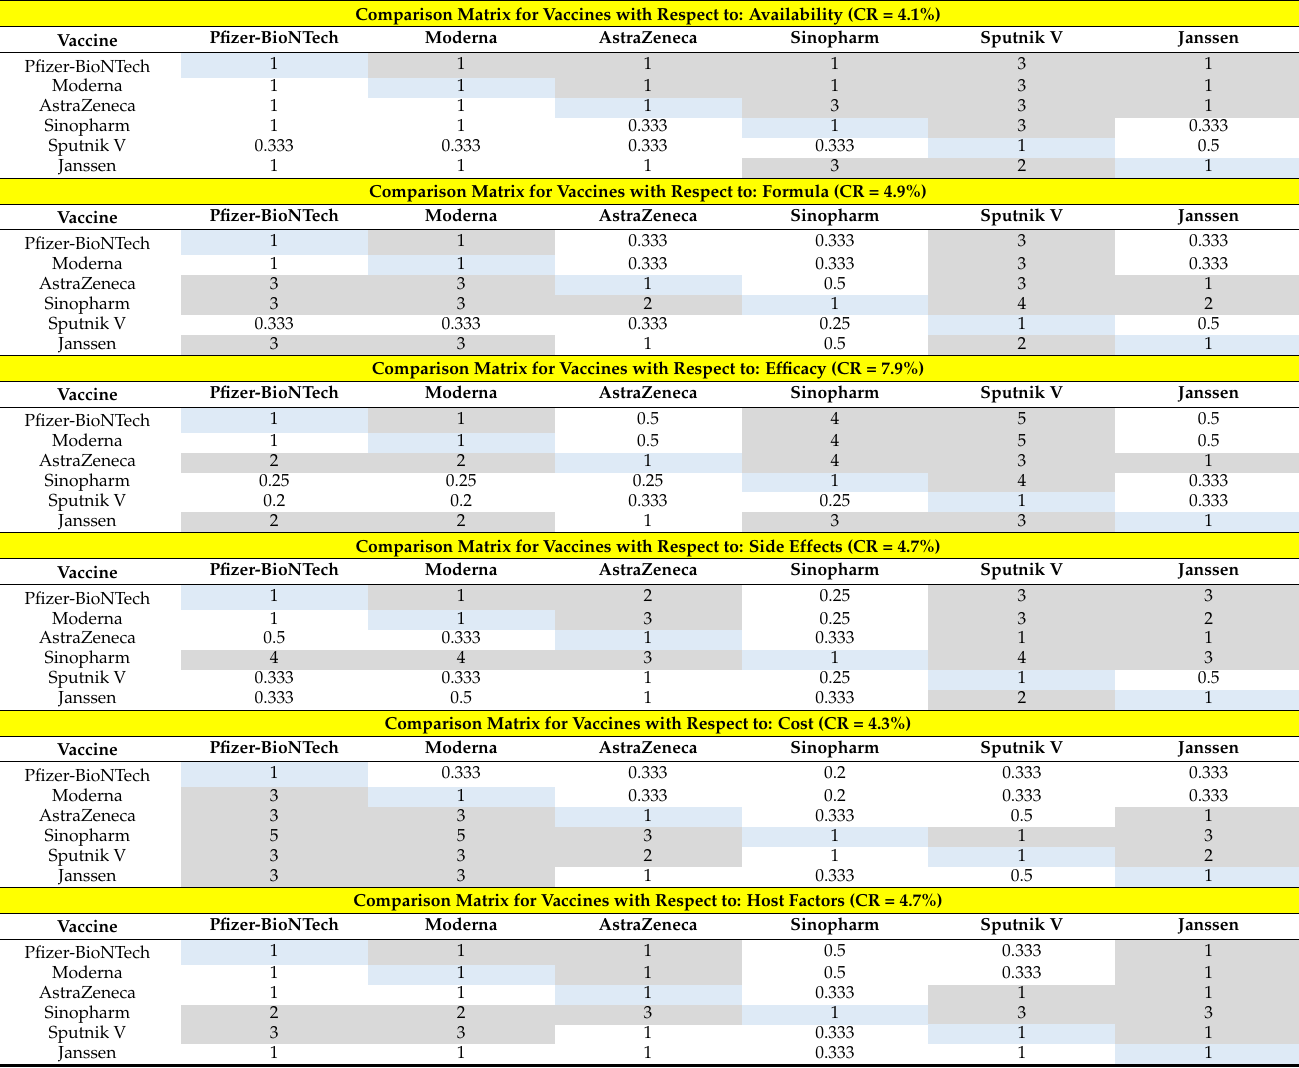
Comparison Matrix for Vaccines with Respect to: Formula (CR = 4.9%)